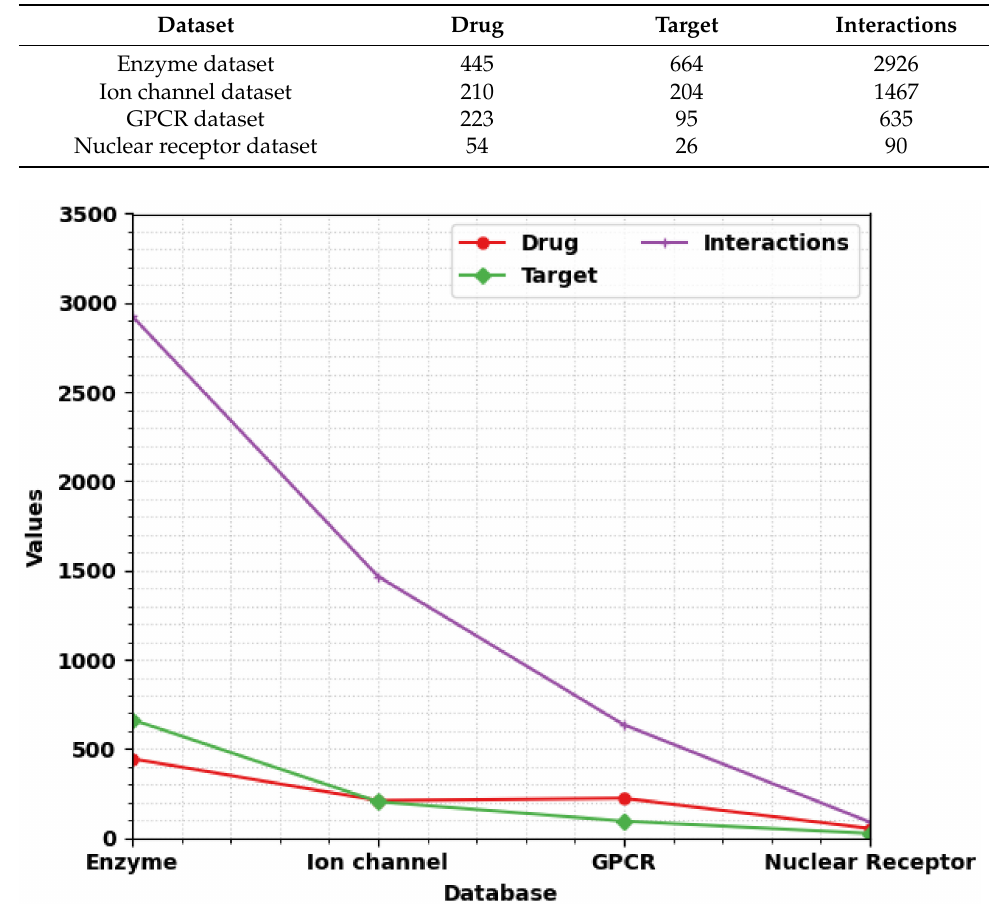
Figure 3. Sample